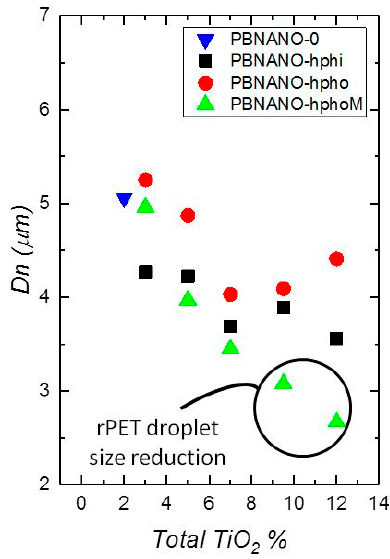
2 content for the